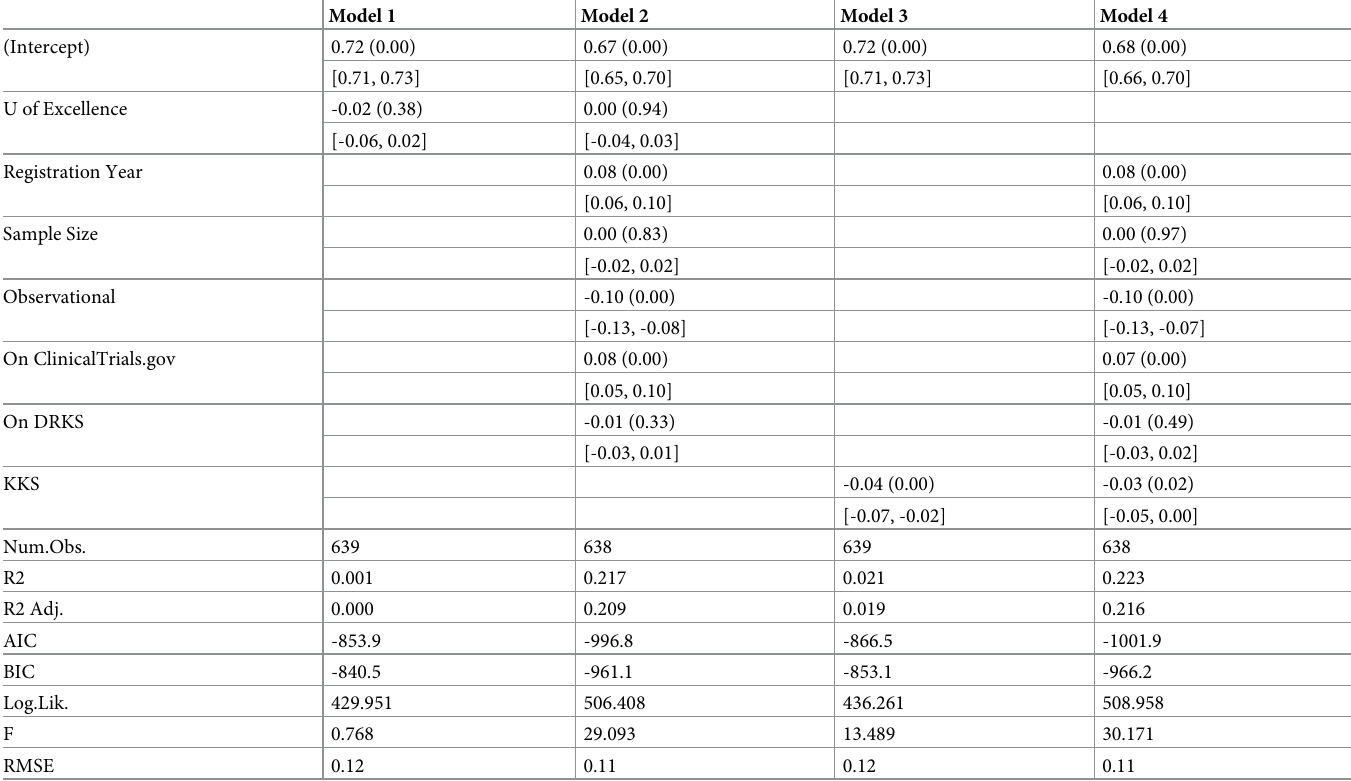
Table 6. Summary of linear regression models predicting mean percentage of attainable registration quality score over all criteria with P-Values in parentheses and 95% confidence